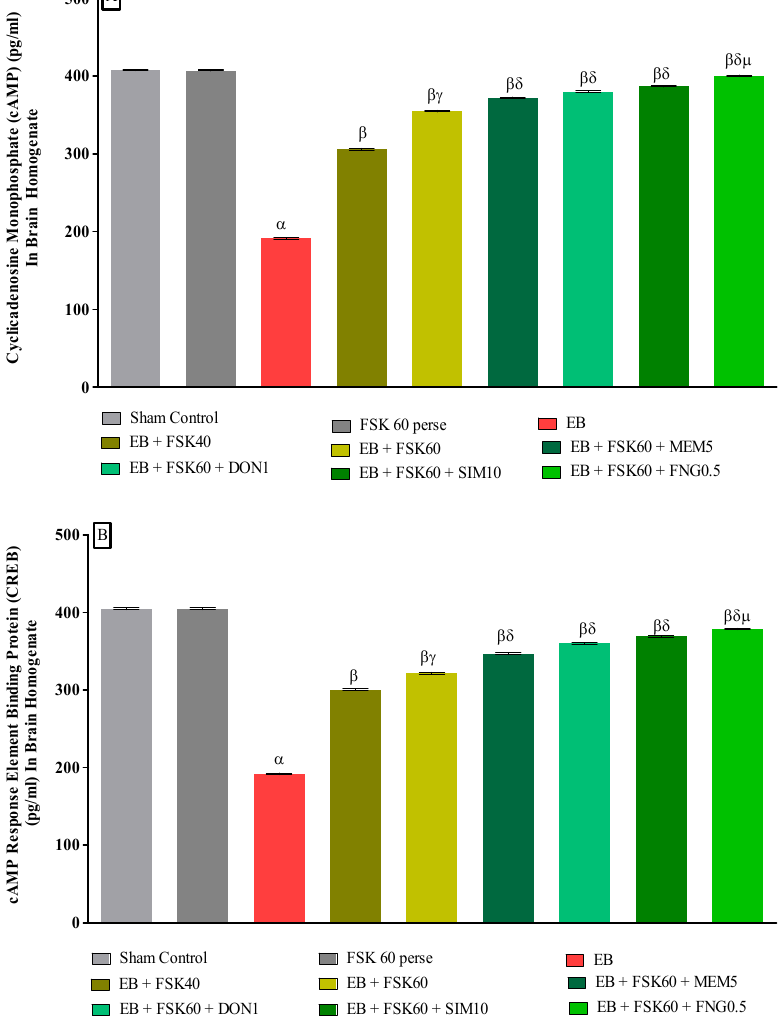
Figure 9. ( A , B ): Protective role of FSK in upregulation of cAMP and CREB levels in experimental multiple sclerosis rats. Analysis of Variance (ANOVA) with Tukey’s test was used to evaluate the data, which were presented as mean with SD ( n = 6). α EB (p < 0.01) v / s Sham control and FSK40 perse; β EB + FSK40, EB + FSK60, EB + FSK60 + MEM5, EB + FSK60 + DON1, EB + FSK60 + SIM10, EB + FSK60 + FNG0.5 (p < 0.01) v / s EB; βγ EB + FSK60 (p < 0.01) v / s EB + FSK40; βδ EB + FSK60 + MEM5, EB + FSK60 + DON1, EB + FSK60 + SIM10, EB + FSK60 + FNG0.5 (p < 0.01) v / s EB + FSK40, EB + FSK60; βδμ EB + FSK60 + FNG0.5 (p < 0.01) v / s EB + FSK60 + SIM10, EB + FSK60 + DON1, EB + FSK60 + MEM5.